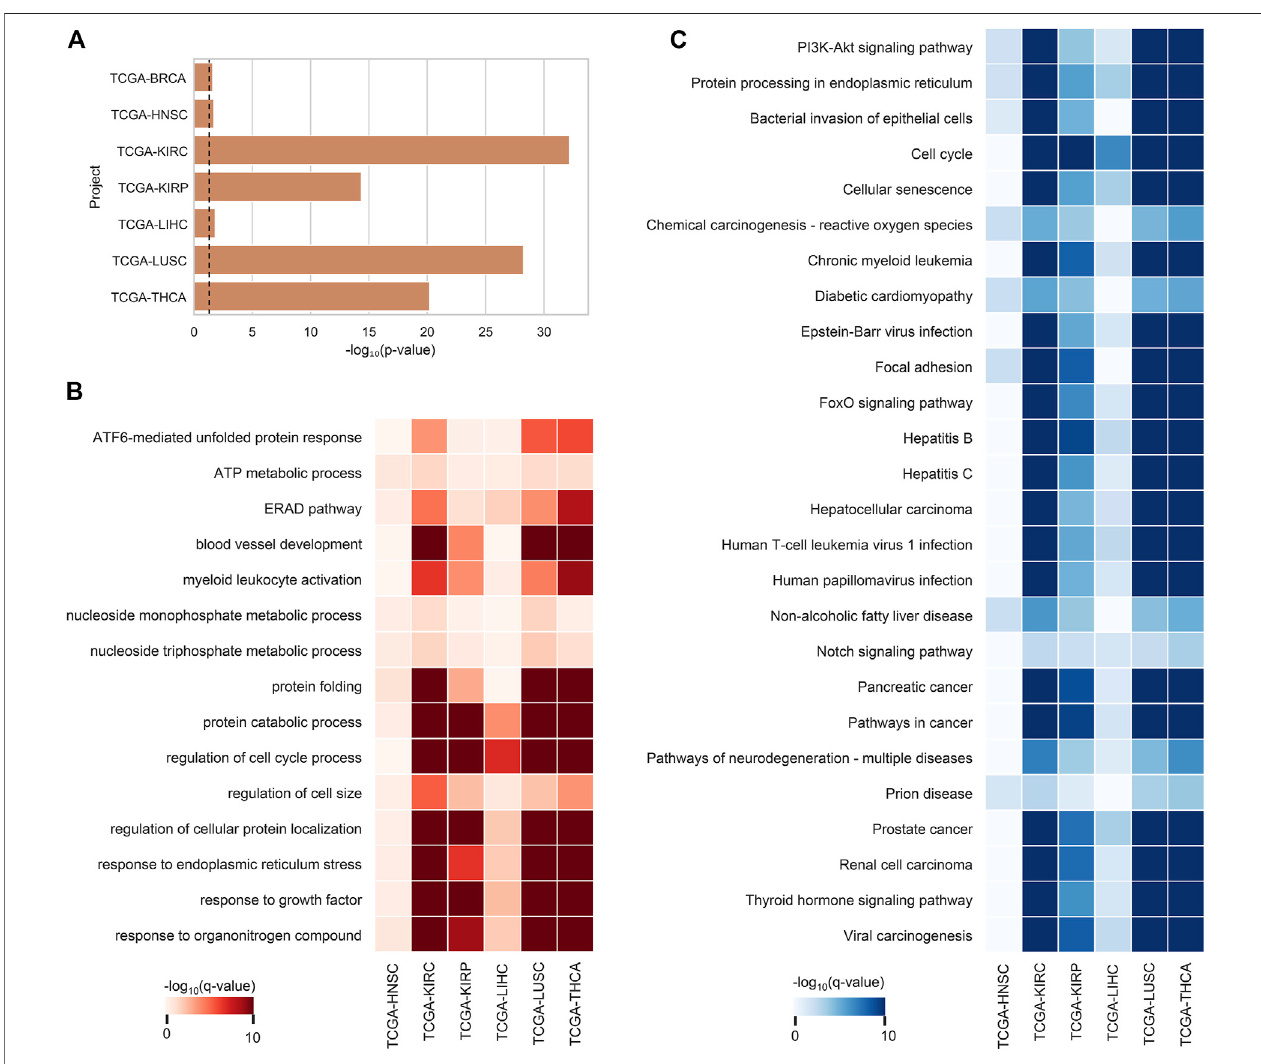
FIGURE5| Enrichmentanalysisresultsofca-tRFtargetgenemodules. (A) Theenrichmentdegreeofcancer-associatedgenes(curatedbyNCGv6.0database)in ca-tRFtargetgenemodules.Thedashedlinerepresentsthestatisticallysigni fi cantcutoff( p -value < 0.05). (B) TheGO-BPenrichmentresultsoftRFtargetgenemodules. Onlythesigni fi cantresults(q-value < 0.05)arecoloredandonlythetermspresentedinnolessthan6cancertypesaredepicted. (C) TheKEGGenrichmentresultsoftRF targetgenemodules.Onlythesigni fi cantresults(q-value < 0.05)arecoloredandonlythetermspresented innolessthan5cancertypesaredepicted.BRCAisnot shown in subplot B and C because there are no signi fi cant